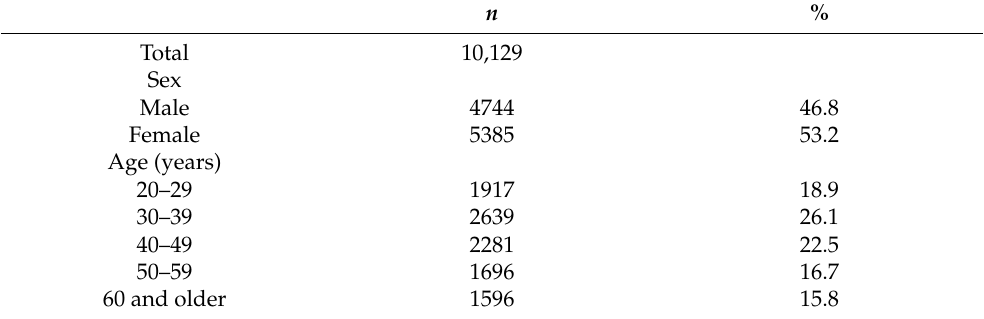
Table 1. Characteristics of respondents.